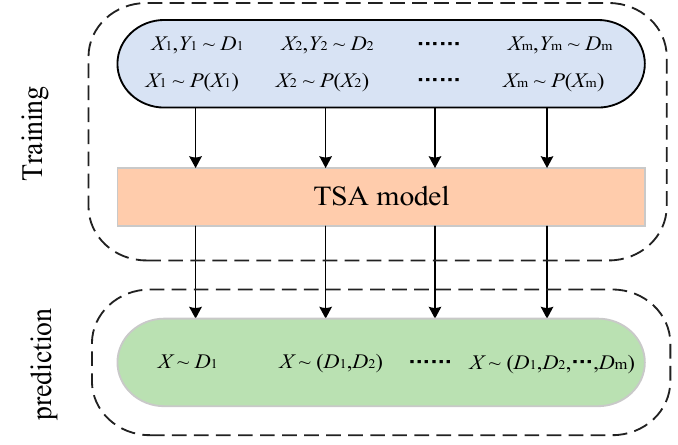
Figure 1. A continual learning scheme.